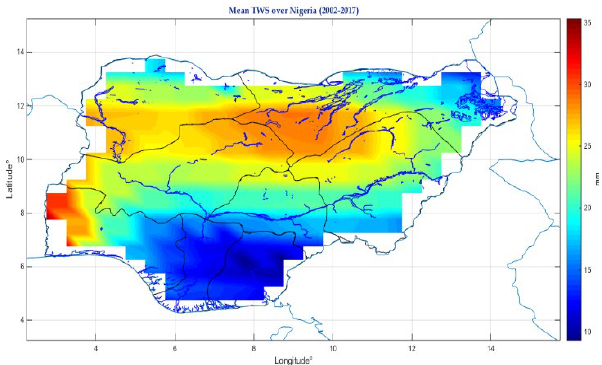
Figure 2. Mean Spatial Distribution of TWS over